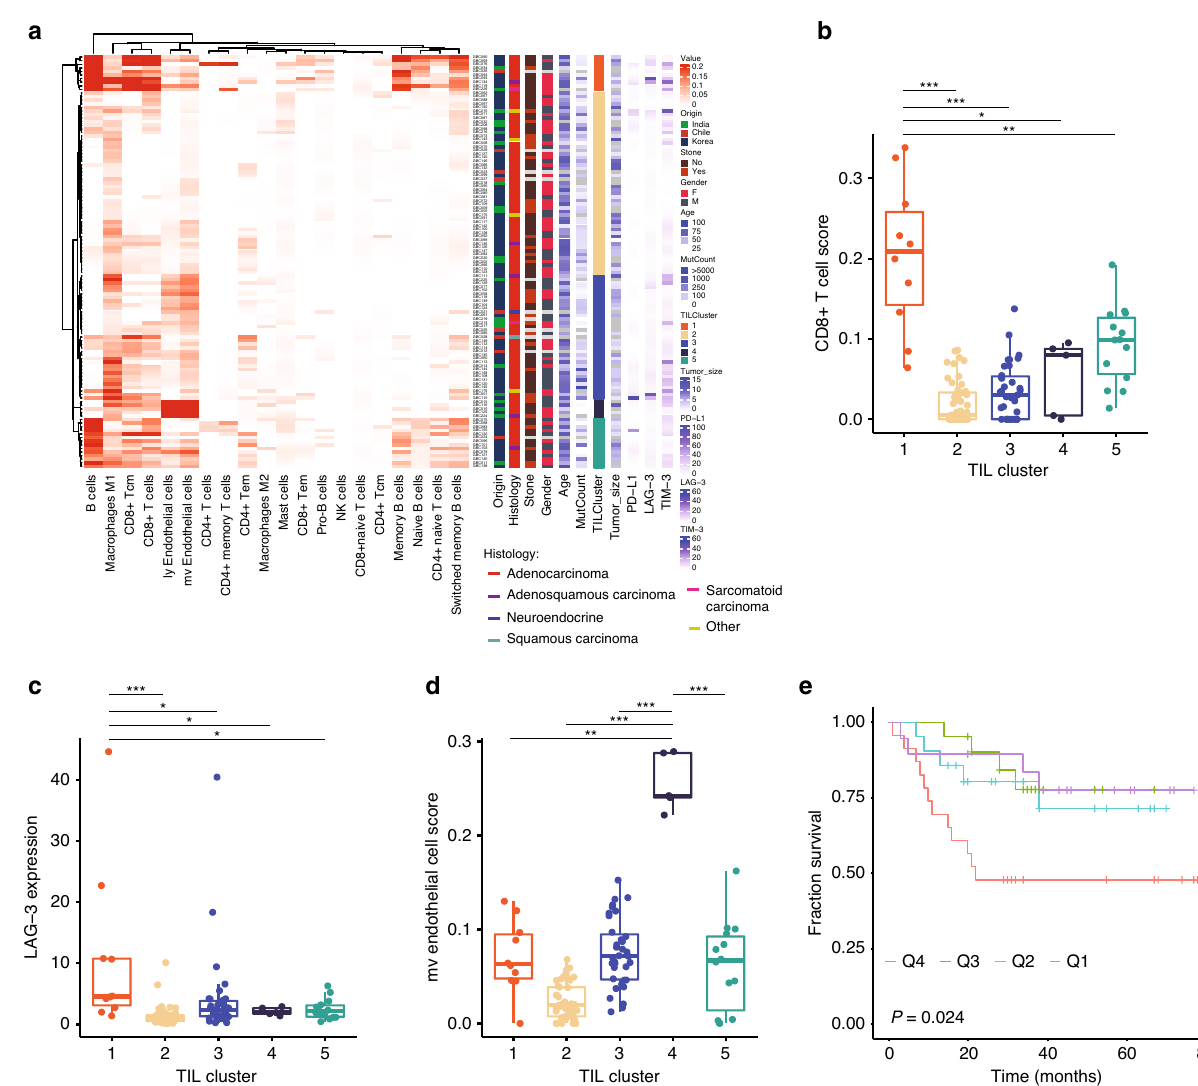
Fig. 4 Tumor-in fi ltrating lymphocyte cluster (TIL) in GBC samples. a RNA-seq based determination of cell types and TIL clusters in GBC samples. TIL cluster and their CD8 + T-cell score ( b ; n = 115), LAG-3 expression ( c ; n = 115), and micro vascular (mv) endothelial cells score ( d ; n = 115). Boxes indicate the interquartile range (IQR); center line, median; whiskers, lowest and highest values within 1.5× IQR from the fi rst and third quartiles, respectively. e Kaplan – Meier survival plot of GBC samples based on mv endothelial cell score quartiles ( n = 21 each arm). Log-rank test p values are presented for